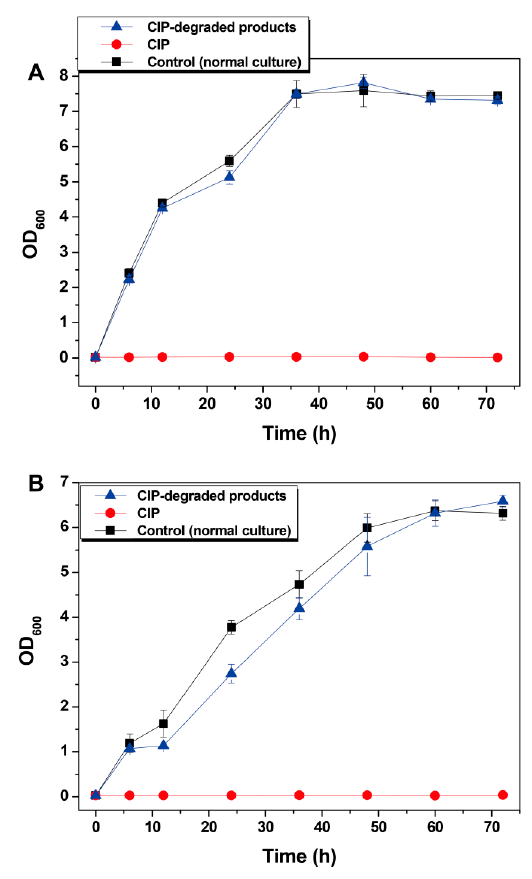
Figure 7. Growth effect of CIP-degraded products on S. aureus KCTC 1621 ( A ) and P. aeruginosa ATCC 15442 ( B ) over a 72 h culture timecourse.